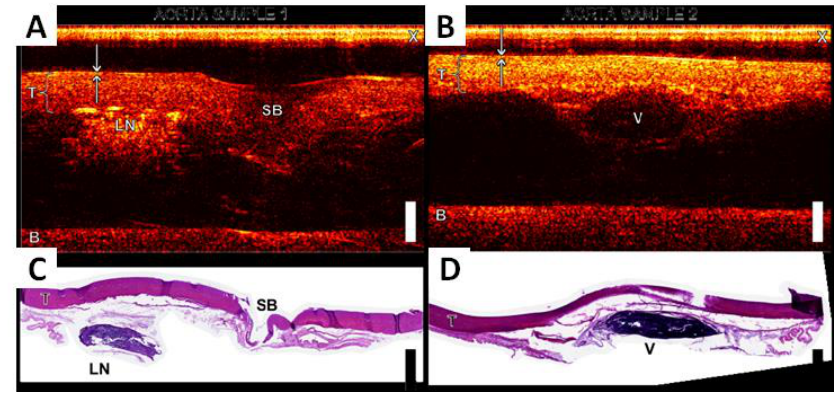
Figure 6. ( A , B ) All-optical ultrasound imaging (AOUSI) of swine aorta samples with a scale bar of 2 mm. B: the base of the tissue mount; LN: a lymph node; SB: a side branch; T: tunica media; V: a vessel; X: cross-talk. Arrows indicate the reflective layers, which may correspond to the intima. ( C , D ) The corresponding histology of aorta sections imaged in ( A , B ), respectively. Reproduced with permission from [77], OSA Publishing,